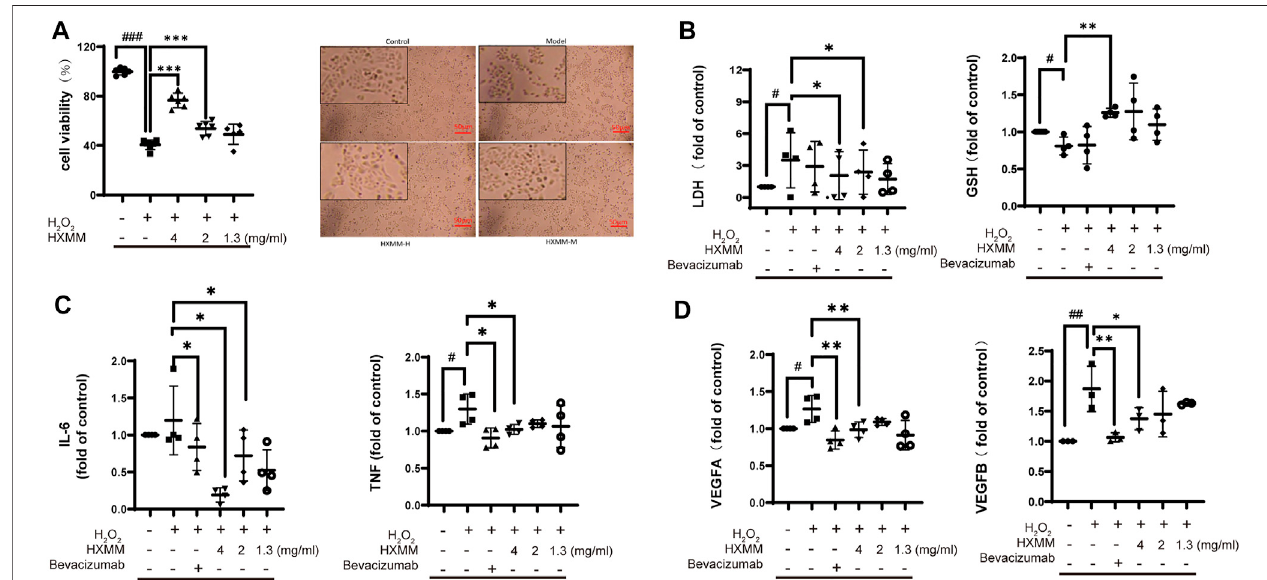
FIGURE 4 | HXMM protects against H 2 O 2 -induced retinal injury in ARPE-19 cells (A) cell viability of viability of ARPE-19 cells treated with H 2 O 2 and HXMM (n = 6), ChangesinARPE-19cellmorphologyinresponsetoHXMMandH 2 O 2 .APRE-19cellswithoutHXMMorH 2 O 2 (control);APRE-19cellswithH 2 O 2 (model);APRE-19cells with4 mg/mland2 mg/mlHXMMandthentreatedby65 μ MH 2 O 2 (HXMM-H,HXMM-L) (B) foldchangeofprocessofoxidativestress,LDHactivity(n=4)andGSHlevel (n = 4) (C) fold change of process of in fl ammation, IL-6 activity (n = 4) and TNF- α level (n = 4) (D) fold change of process of angiogenesis, VEGFA level (n = 4) and VEGFB (n = 4). Data were expressed as the mean ± SD, # p < 0.05 versus control, * p < 0.05 versus model was considered signi fi cant, ** p < 0.01 was considered signi fi cant statistical difference, *** p < 0.001 was considered extremely signi fi cant statistical difference.